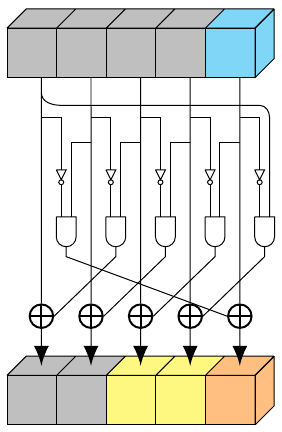
Figure 5: Fixing the bit in blue before χ enables one to obtain a linear expression of each bit in yellow. The bit in blue has the same value as the bit in orange with probability 0 . 75.